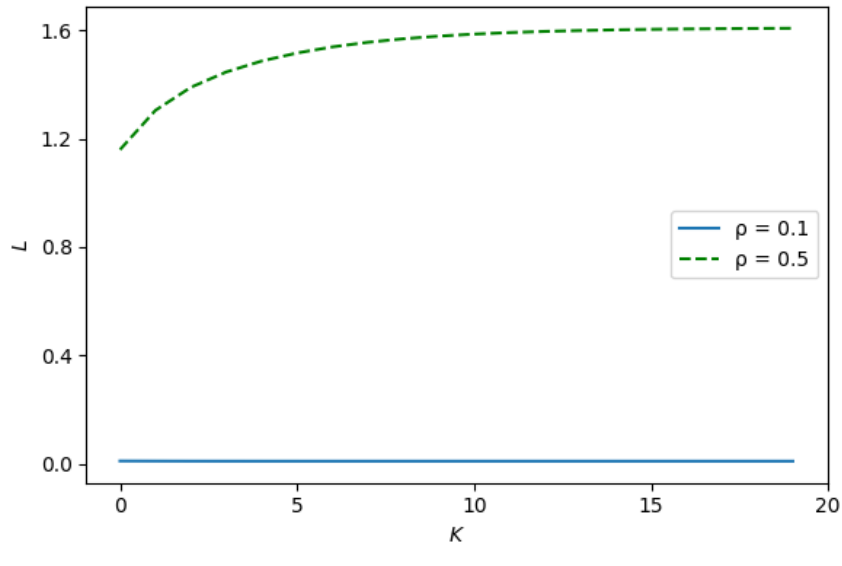
Figure 1. L vs. K for system loads ρ = 0.1 and ρ = 0.5.